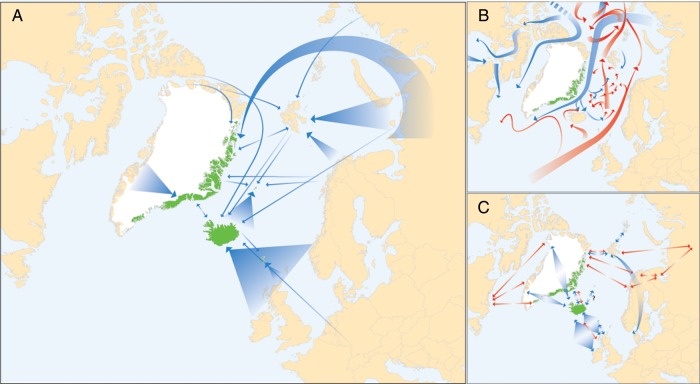
(A) Main (thick arrows) and additional (thin arrows) LDD routes of plants in the North Atlantic area inferred from genetic and floristic data (cf. Fig. 1). (B) Sea surface circulation patterns in the North Atlantic area (blue: cold water, red: warm water). (C) Main migration routes for geese species (thick blue arrows) and the supposedly efficient seed disperser Plectrophenax nivalis (snow bunting, thin red arrows) in the North Atlantic area (based on Madsen et al. 1999; Lyngs 2003).